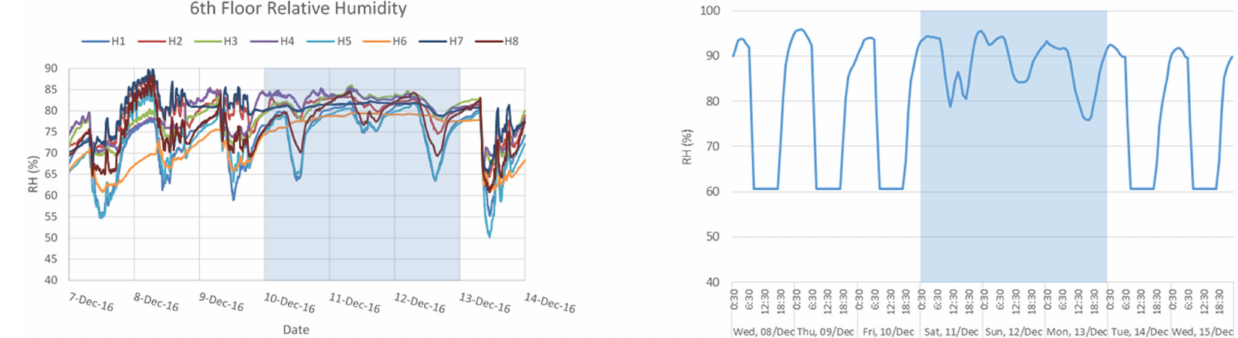
Figure 7. Readings of relative humidity for 7 days in level 6 (field measurements on the left and simulation results on the right ) [18].